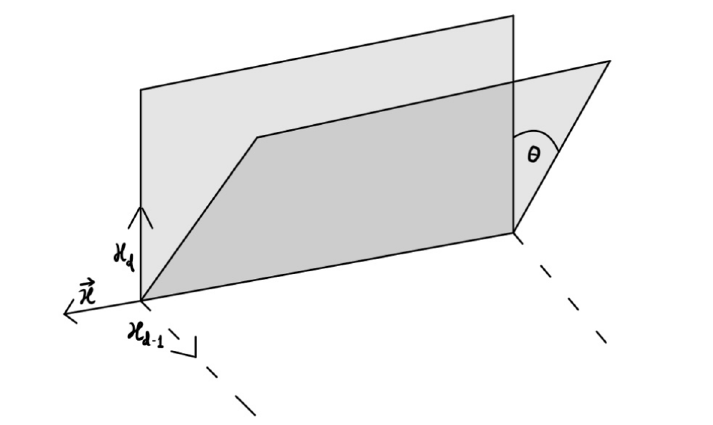
Figure 1 . Setup for CFT near two intersecting boundaries forming an angle θ